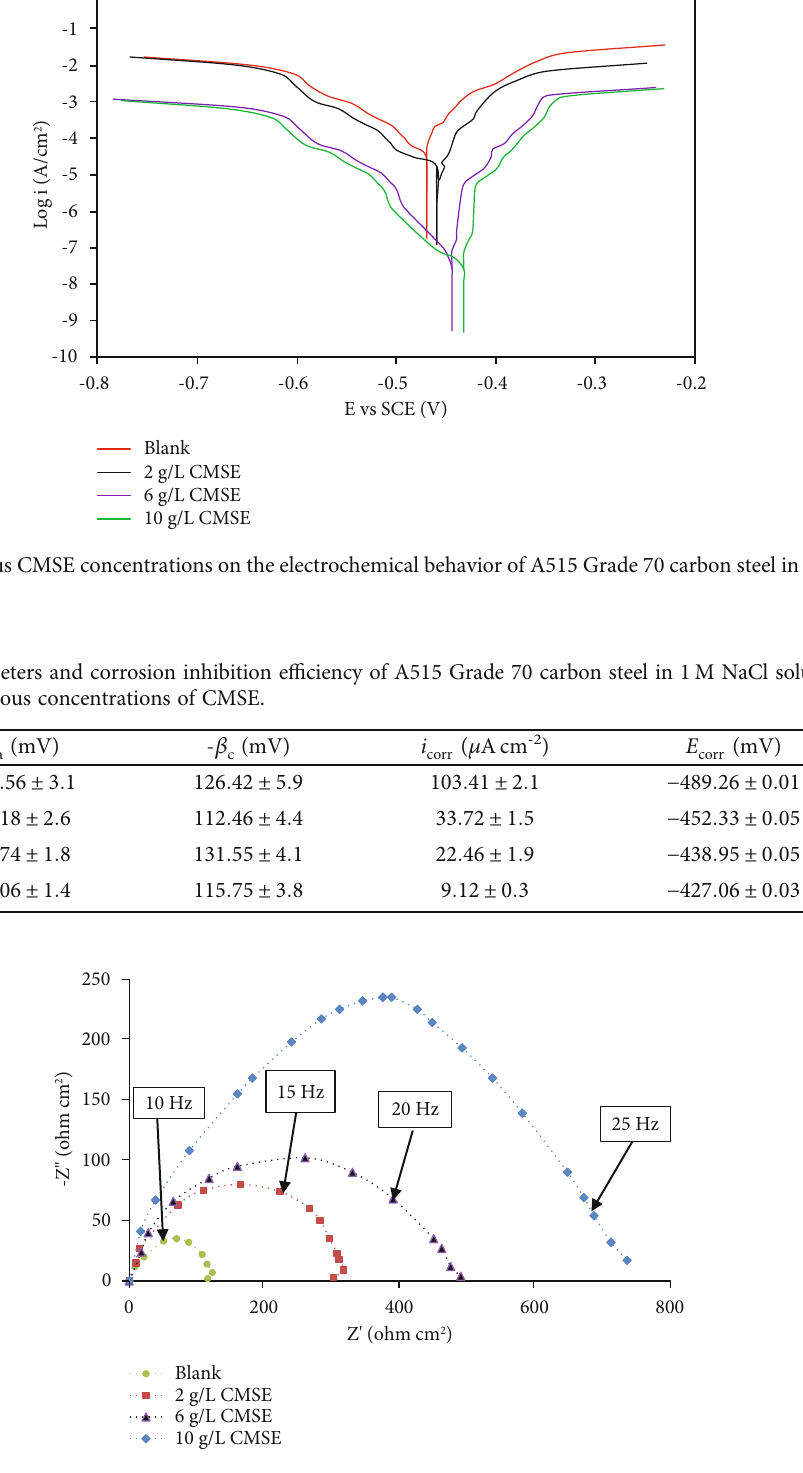
Figure 2: Nyquist plots of carbon steel in in 1M NaCl solution at 303K in the absence and presence of various concentrations of CMSE.